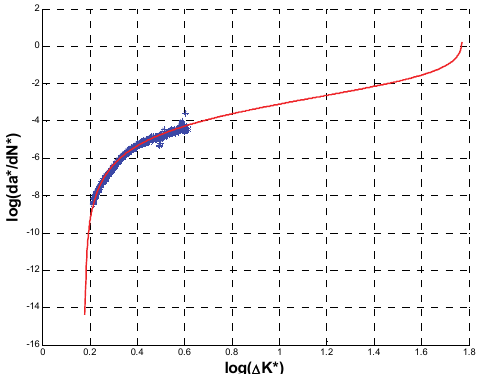
Figure 6: Representation of the normalized experimental data and fitting obtained.